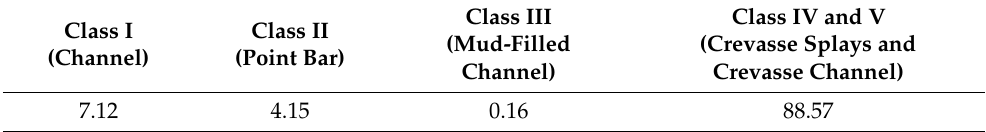
Figure 5. Detailed description of fluvial facies elements, as observed in time slice 1564 milliseconds. Table 2. The percentage of pixels for each facies class in the training dataset of A